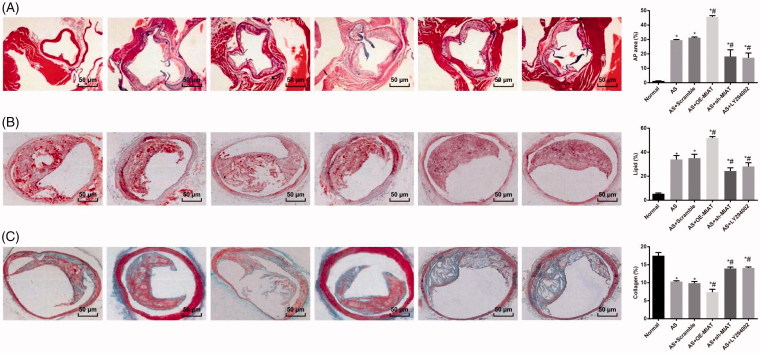
MIAT promotes AP formation, increases the lipid content and decreases the collagen content of AP in AS mice by activating the PI3K/Akt signaling pathway. (A) AP formation in aorta of mice in each group was observed by HE staining (× 200). (B) Lipid content in aorta of mice in each group was observed by oil red O staining (× 200). (C) Content of collagen in aorta of mice in each group was measured by Masson staining (× 200). N = 5. One-way ANOVA was used for data analysis, and LSD-t test was used for comparison after ANOVA. * p < .05 versus the normal group; # p < .05 versus the AS group.